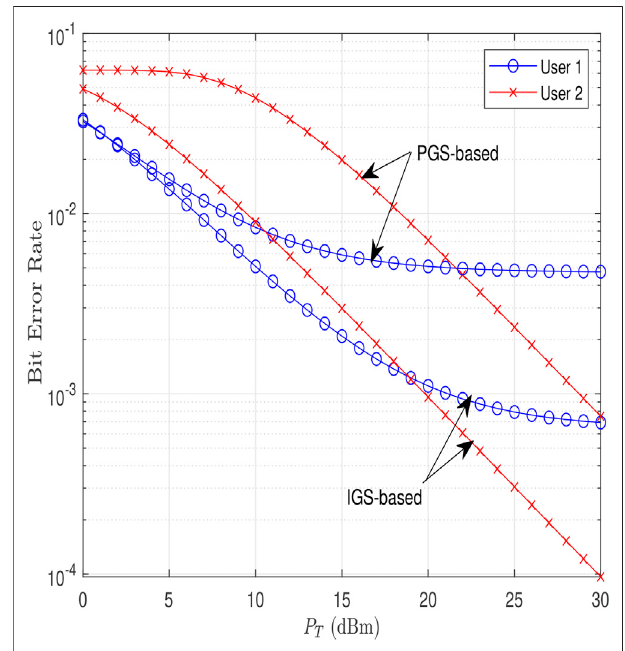
FIGURE 7 | Energy ef fi ciency vs. P (dBm) at different values of P c for proposed Algorithm 2 and exhaustive search.